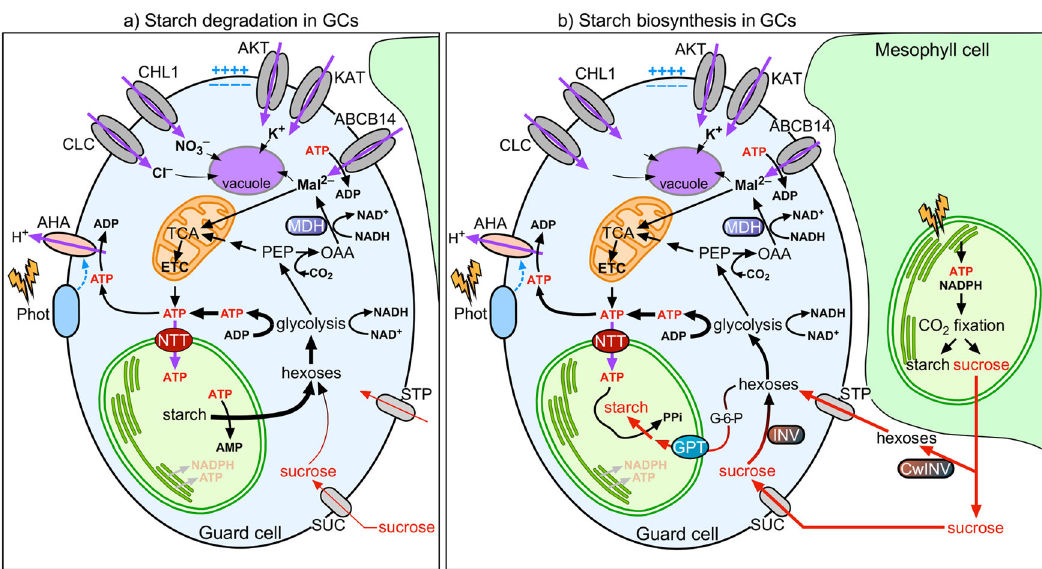
Fig. 6 Model of the coordination of stomatal function with starch and malate metabolism in guard cells. a Guard cell (GC) starch is broken down at the initial phase of illumination. At dawn, the GC plasma membrane-associated photoreceptor kinases PHOT1 and PHOT2 are activated by low-irradiance blue light to induce stomatal opening 6 . In parallel, GC starch is mobilized to sustain sugar homoeostasis for stomatal opening 13 . Sugars are also an energy source for GC mitochondria to generate ATP and reducing equivalents 35 . Through glycolysis, sugars are converted to PEP, a 3C compound, which can fi x one CO 2 molecule and be further converted into OAA, a 4C compound, via the action of PEPc (phospho enol pyruvate carboxylase). OAA is then further reduced to Mal 2 − by MDH 35 . Mal 2 − is imported to the vacuole to contribute to GC osmoregulation and stomatal opening and acts as a counter-ion for K + 76 . Mal 2 − can also be directly imported from the apoplast 58,77 . At the same time, carbon fi xation and starch/sucrose biosynthesis occur in mesophyll cells. b Starch biosynthesis occurs in GCs after the initial phase of illumination. After complete starch degradation in GCs, stomatal opening is sustained by mesophyll cell-derived sugars 10,49 . Hexoses, derived from sucrose from neighbouring mesophyll cells through the action of cell wall invertase, are imported to GCs via the monosaccharide/H + cotransporters STP1 and STP4 10,78 . In GCs, hexoses are converted into glucose-6-phosphate, which is then transported into the chloroplast through Glc-6-P/Pi translocators and can be utilized for starch biosynthesis 33,79 . The imported sugars can also be metabolized through glycolysis 18 and mitochondrial respiration to generate cytosolic ATP that enters GCCs via ATP/ADP antiporter NTTs to deliver ATP for starch biosynthesis. Chloroplasts and mitochondria are represented by green and brown circles, respectively. Red arrows represent the energy source fl ow. ADP Adenosine diphosphate; AHA H + -ATPase; AKT Inward-rectifying K + channel; AMP Adenosine monophosphate; ATP Adenosine triphosphate; CHL1 Dual-af fi nity nitrate transporter; CLC Chloride channel of the CLC gene family; CwINV Cell wall invertase; G6P Glucose-6-phosphate; GPT Glucose-6-phosphate/Pi translocator; H + Proton; K + Potassium; KAT Inward-rectifying K + channel; MDH Malate dehydrogenase; NTT Nucleotide transport protein; OAA Oxaloacetate; PEP Phospho enol pyruvate; Phot Phototropin; STP Sugar Transport Protein; SUC Sucrose /H + cotransporter; V Vacuole. Imported ions and sugars are stored in the